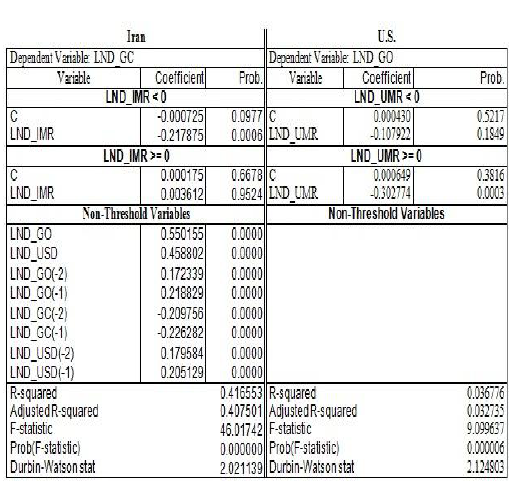
Table 5: Manually Applying the Regimes to the Relationship of the Daily Return of the U.S. and Iran's Stock Markets with Gold Method: Threshold Regression Threshold type: Fixed number of user-specified thresholds Threshold value used: 0